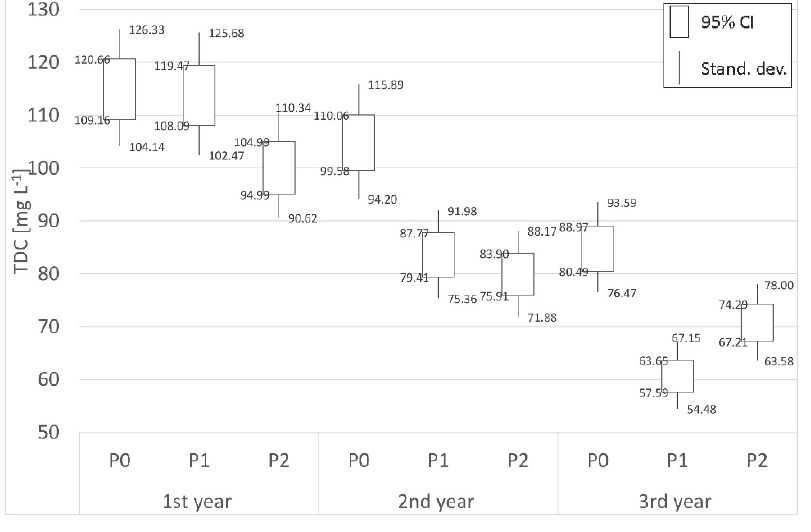
Figure 3. The concentrations of TDC in groundwater under shelterbelt. Table 4. Mean concentrations of TDC and DOC in groundwater under peatland and shelterbelt soils. Peatland